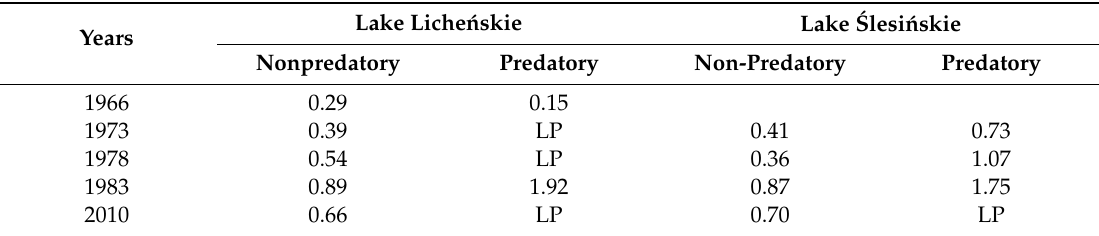
Table 3. Mean summer daily P:B coe ffi cient (daily production to biomass in units of wet weight) for nonpredatory and predatory rotifers in the Konin lakes in di ff erent years of study. Data for 1966 are derived from [54], for 1973 according to [25], and for 1978 and 1983 according to [54]. LP—lack of predatory